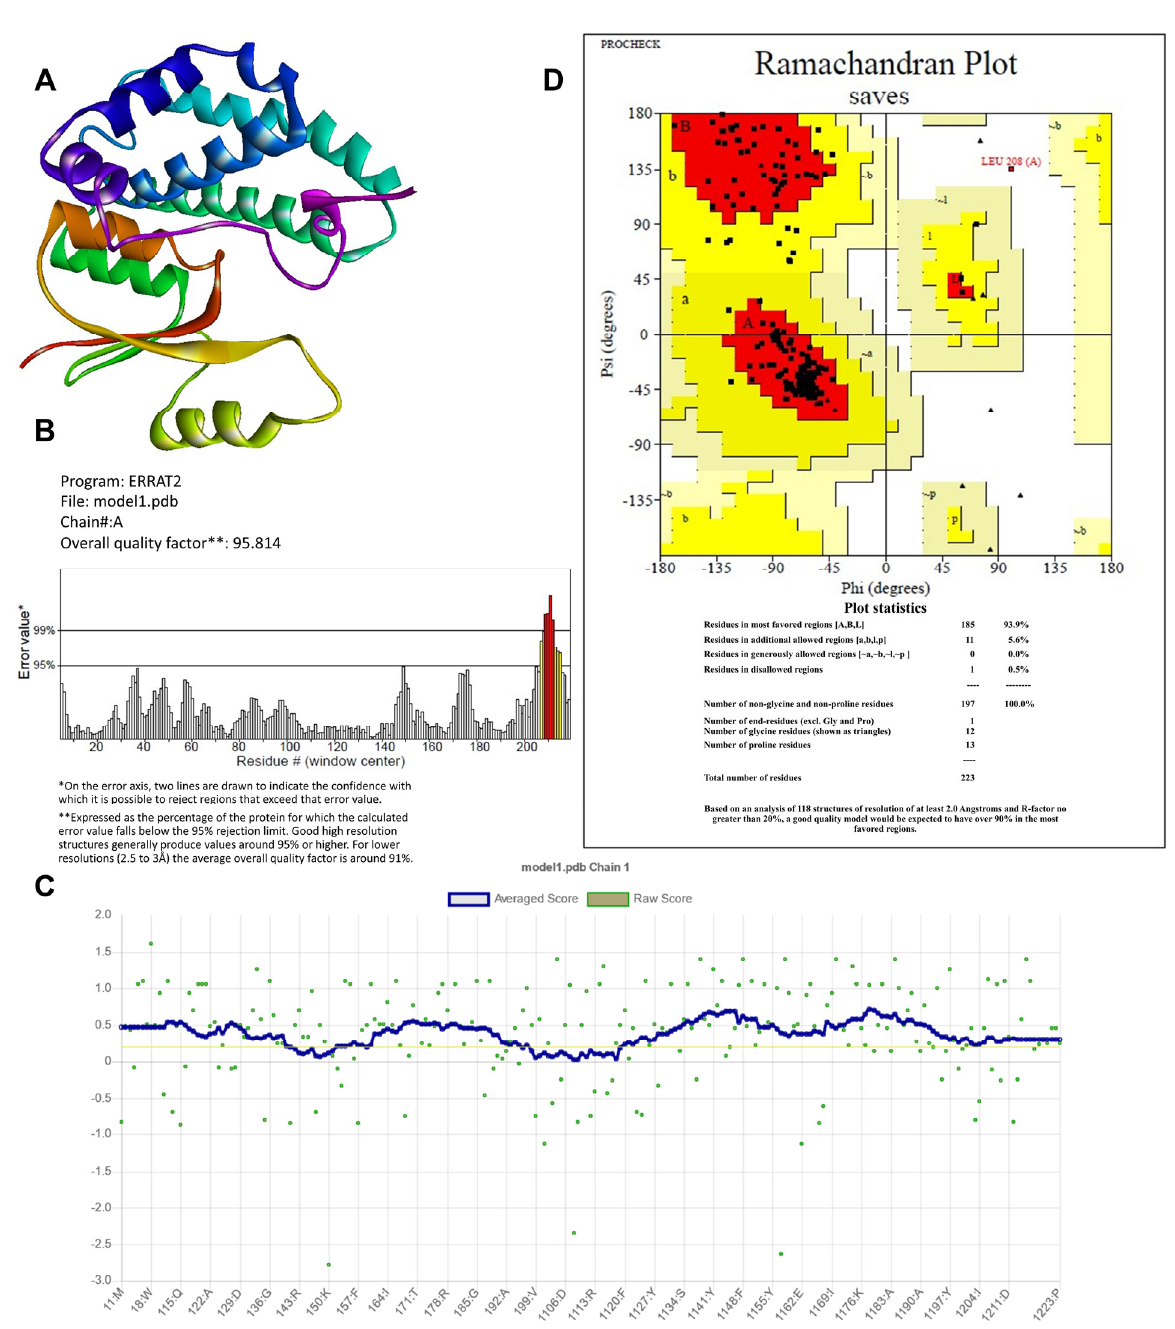
Figure 2. ( A ) Rhipicephalus microplus glutathione S-transferases (RmGST) three-dimensional (3D) structure predicted by the trRosetta server; ( B – D ) ERRAT, Z-scores, and Ramachandran map, respec- tively, validate the protein structure and amino acid position of RmGST. The Ramachandran plot of RmGST indicates the percentage of residues in favored regions (red) and allowed regions (yellow) where the bars in the ERRAT plot represents the error value (white: error < 95%, yellow: error < 99%, and red: error >